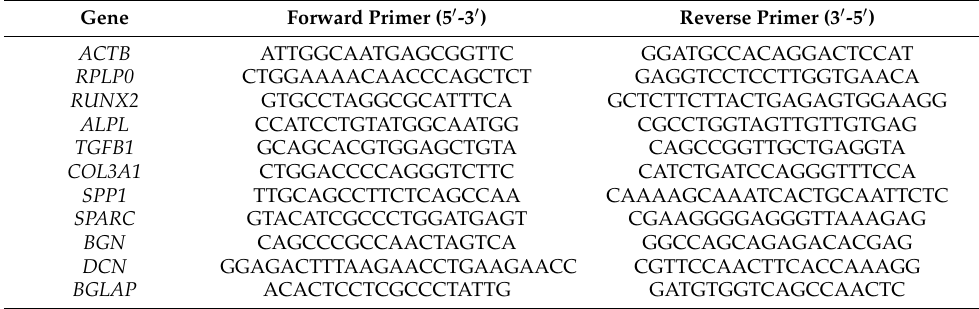
Table 3. List of primers used in gene expression analysis by